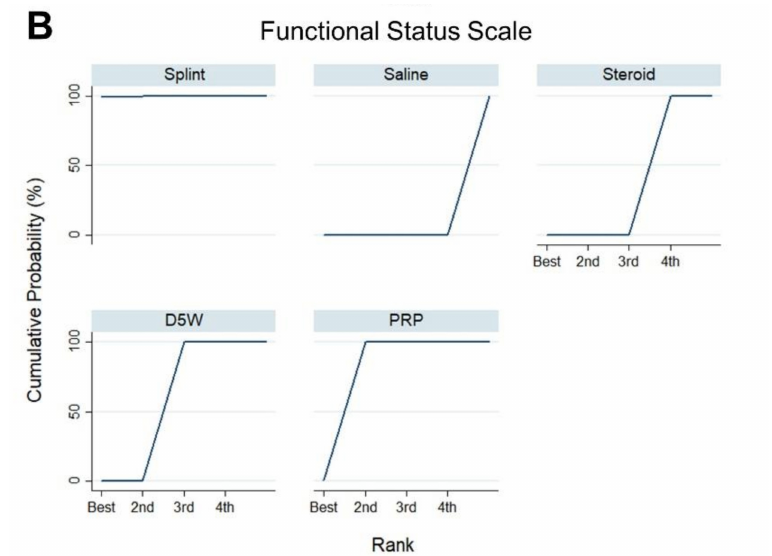
Figure 4. Ranking probabilities for di ff erent subgroups based on the standardized mean di ff erence between di ff erent subgroups in terms of the ( A ) symptom severity scale and ( B ) functional status scale of the Boston Carpal Tunnel Questionnaire. PRP, platelet-rich plasma; D5W, 5%